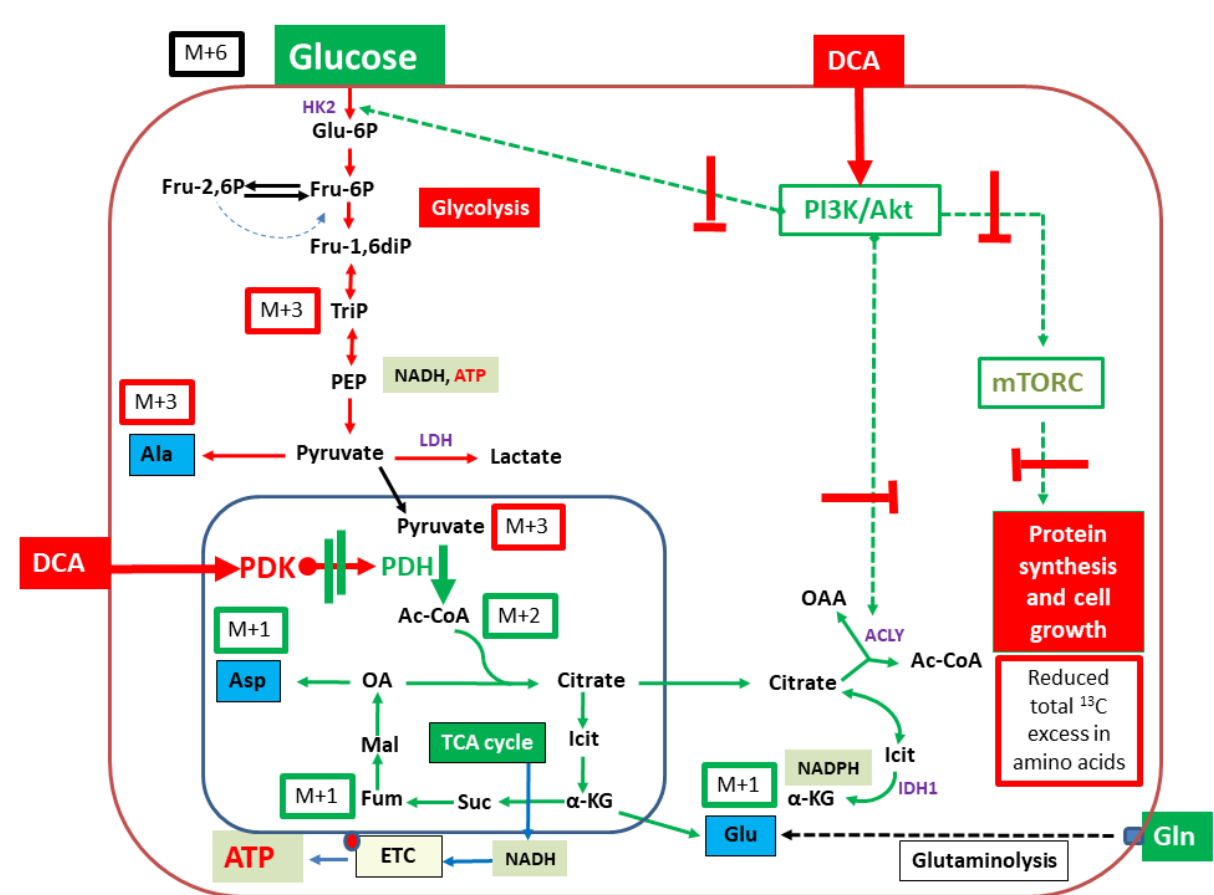
Figure 6. Model for DCA-induced effects upon the core metabolism in 9580 and 10,158 cancer cells. Green arrows and symbols indicate increased metabolic activities and stimulatory effects. Red arrows and symbols indicate reduced metabolic activities and inhibitory effects. Notably, glucose utilization via glycolysis could be reduced due to the deactivation of PI3K/Akt. Flux via the TCA cycle and oxidative phosphorylation could be increased by PDH activation due to inhibition and deactivation of PDK. When starting from [U- 13 C 6 ]glucose (M + 6) as a carbon substrate, effects on the relative fractions of 13 C-isotopologues in key metabolites and amino acids (in blue boxes) are indicated in red when reduced by DCA or in green when increased by DCA. M + 3, M + 2 and M + 1 indicate molecules carrying three, two or one 13 C-atoms, respectively. PDH, pyruvate dehydrogenase; PDK, pyruvate dehydrogenase kinase, ETC, electron transfer chain; HK2, hexokinase 2; ACLY, ATP-citrate lyase; IDH1, isocitrate dehydrogenase